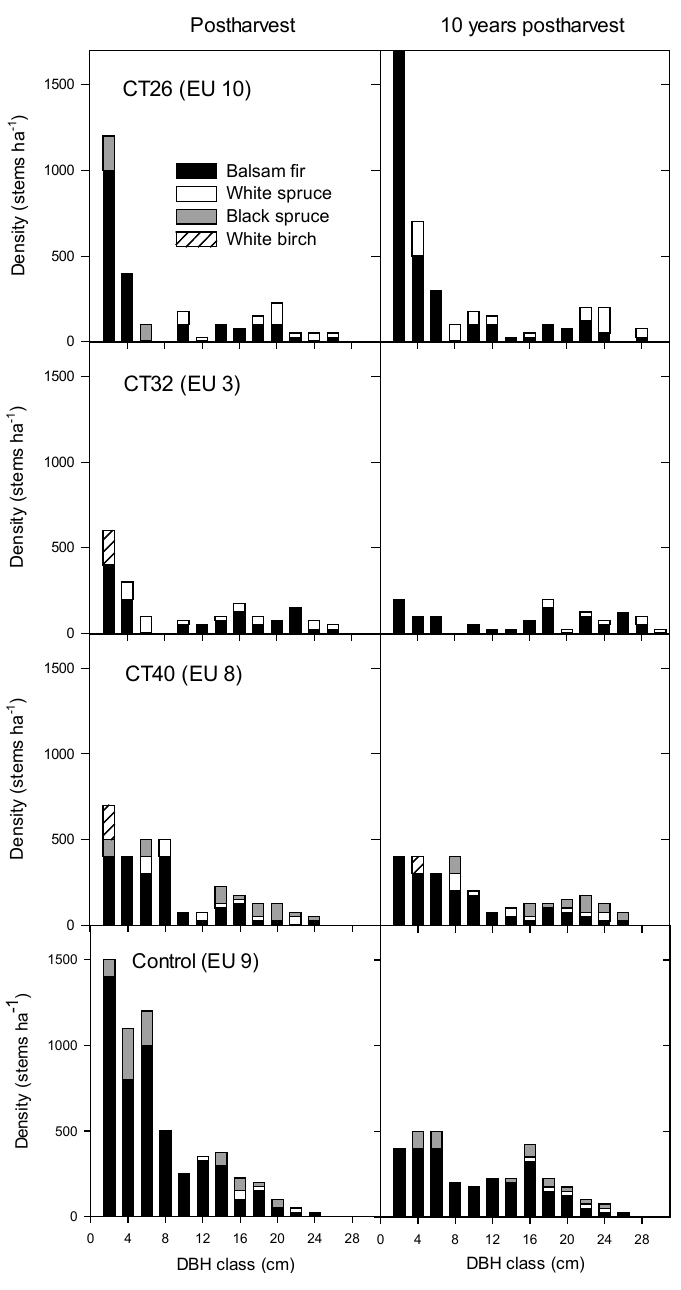
Figure S2. Diameter distribution (2-cm classes) of experimental units (EUs) in each commercial thinning treatment: 26% (EU 10), 32% (EU 3) and 40% (EU 8) merchantable basal area removals and an unthinned control (EU 9). Distributions are presented immediately postharvest and 10 years after